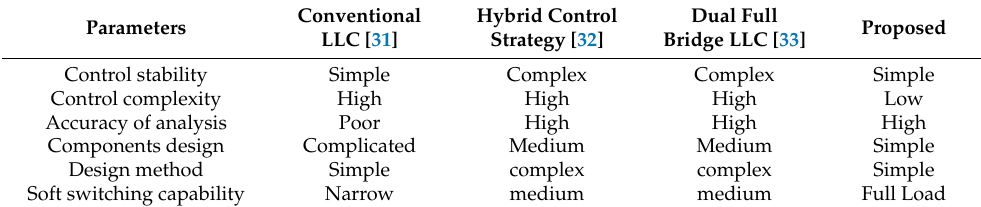
Table 2. Comparison Table of Proposed Topology with other Methods.